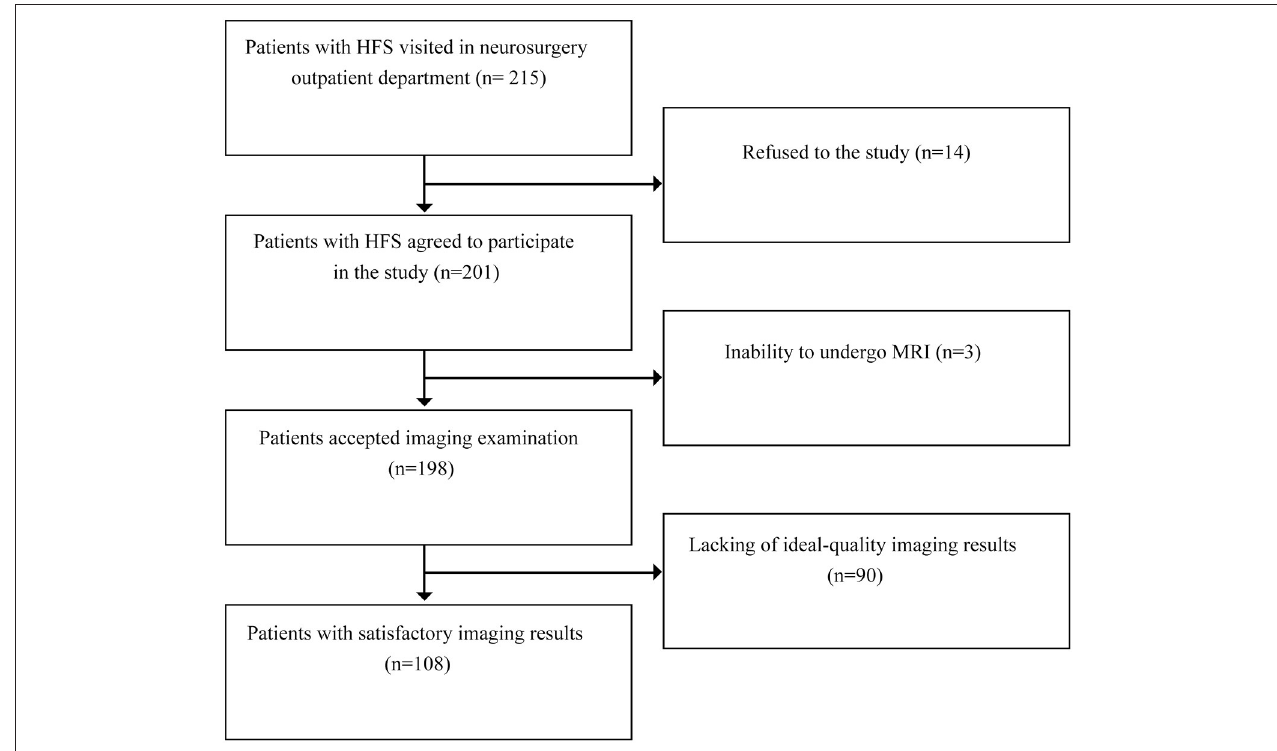
FIGURE 3 | Flow diagram of literature search and study selection.